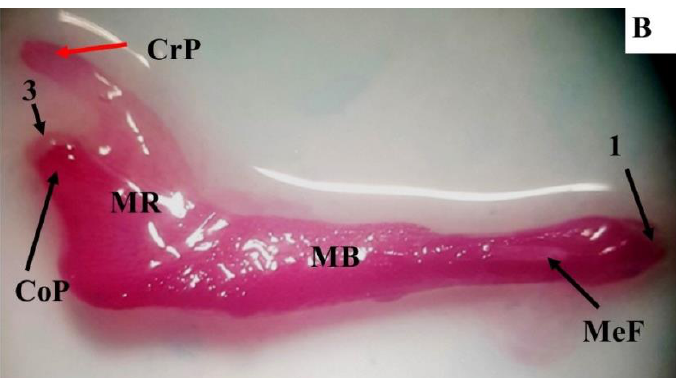
Figure 4. A stereomicrograph of the lateral views of the mandible of a 51 st (A) and 66 th (B) days old Uda fetus showing the ossifying mandibular body (MB), mandibular rami (MR), ossification centres (red arrows), ventral border (2) coronoid process (CrP), condyloid process (CoP) and its fibrous extremity (3), cartilaginous alveolus for incisors teeth (1) and ossified alveolus for incisors teeth (4), and mental foramen (MeF), Alizarin red stain (X5).